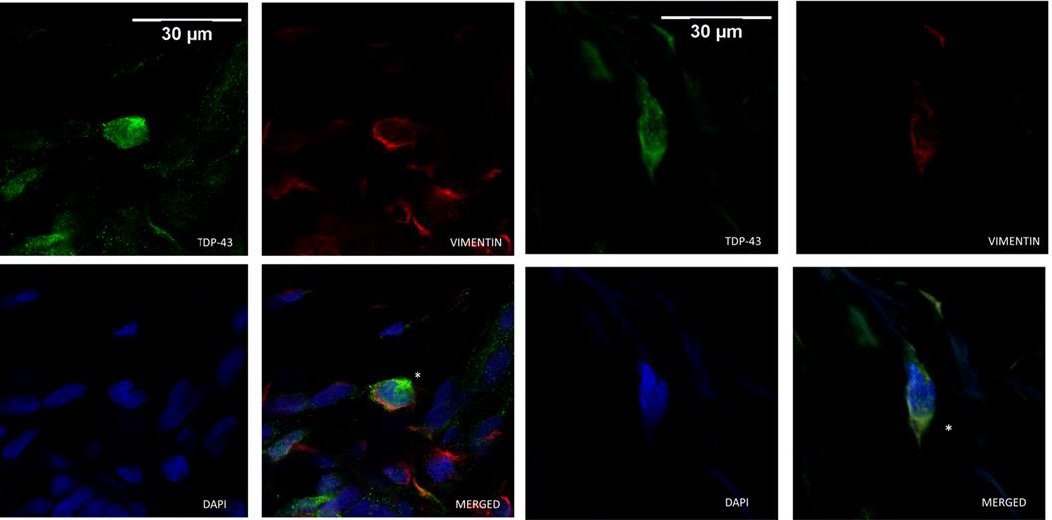
Figure 3. Cytoplasmic TDP-43-positive cells (*) were identified as fibroblasts based on vimentin im- munoreactivity. Representative confocal microscopy images of ALS dermal fibroblasts co-immuno- labeled for TDP-43 (in green), vimentin (in red) and DAPI nuclear staining (in blue).